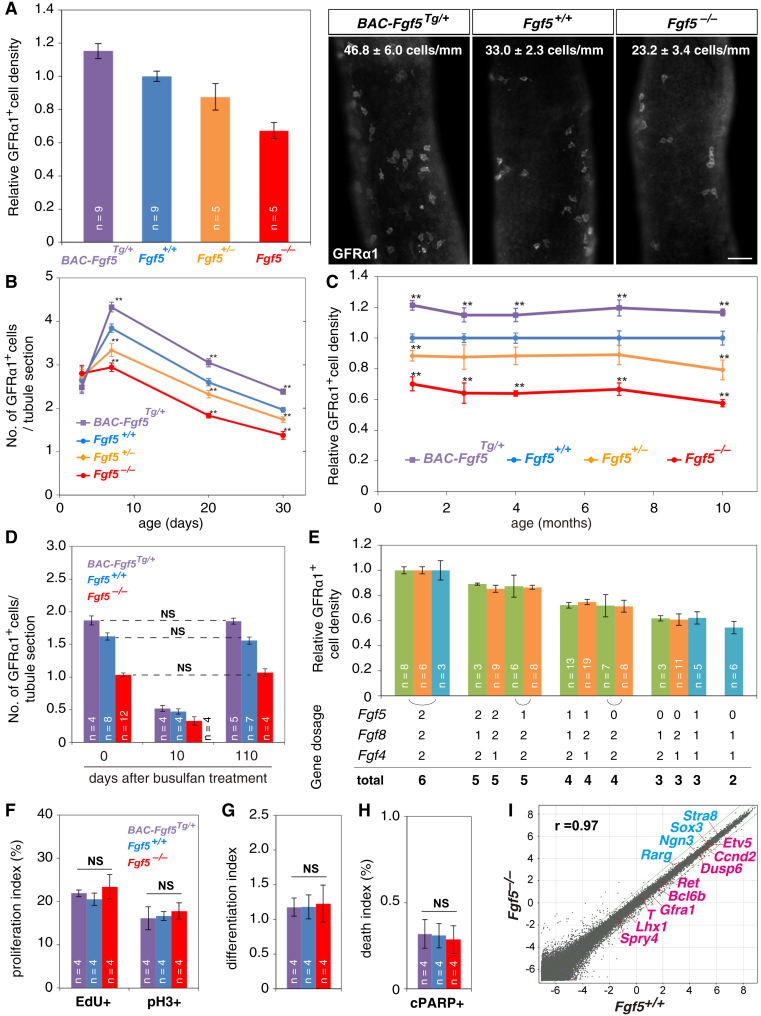
Dosage of Fgf Genes Quantitatively Determines the Density of GFRα1+ Cells(A) Average densities ± SEM of GFRα1+ cells and representative IF images of whole-mount seminiferous tubules for GFRα1 of 2.5-month-old mice with indicated genotypes. Scale bar, 50 μm. n, number of mice examined.(B and C) Average densities ± SEM of GFRα1+ cells in mice with indicated genotypes during young (B) and adult (C) ages. **p < 0.05 compared to Fgf5+/+.(D) Recovery of the GFRα1+ cell densities following busulfan treatment in adult mice with indicated genotypes. NS, not significant (t test).(E) Relative average densities ± SEM of GFRα1+ cells in mice harboring the indicated dosages of functional Fgf5, Fgf8, and Fgf4 alleles. Results from Fgf5-Fgf8 (green), Fgf5-Fgf4 (orange), and Fgf5-Fgf4-Fgf8 (cyan) intercrosses were shown separately, given their different genetic backgrounds (Figures S5J and S5K).(F–H) Indexes of proliferation (EdU+ and pH3+ fractions; F), differentiation (quantified as the RARγ+/KIT− [≈NGN3+] over GFRα1+ cell ratio; G), and death (cPARP+ fraction; H) in GFRα1+ cells of indicated mice at 2.5 months of age.(I) Global gene expression profiles in GFRα1+ cells of 2.5-month-old Fgf5+/+ and Fgf5−/− mice, indicating some positive (red) and negative (blue) FGF5 targets (Figure 2G). r, Pearson’s correlation coefficient.